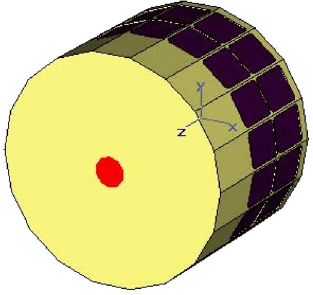
FIG. 6. (Color) MWS model of the prototype absorber with tiled bricks and axial